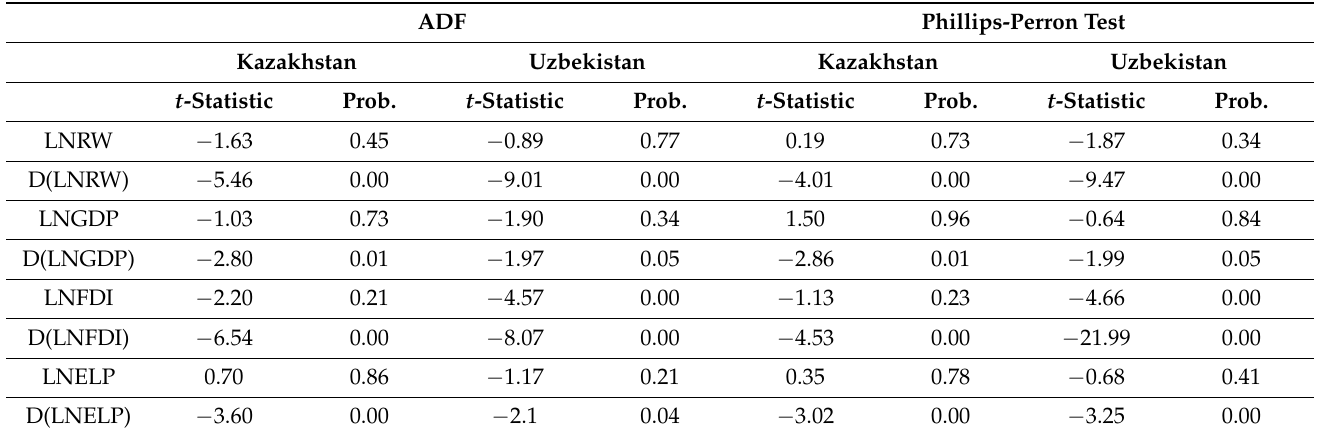
Table 2. Unit root test.